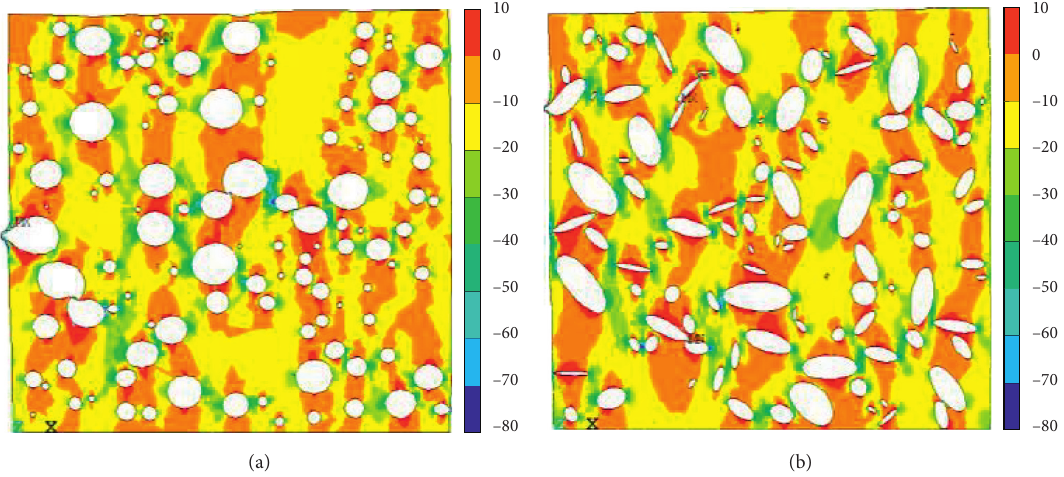
Figure 12: Stress cloud in simulation model for specimen 2#: (a) random circular pores model; (b) random ellipse pores model.